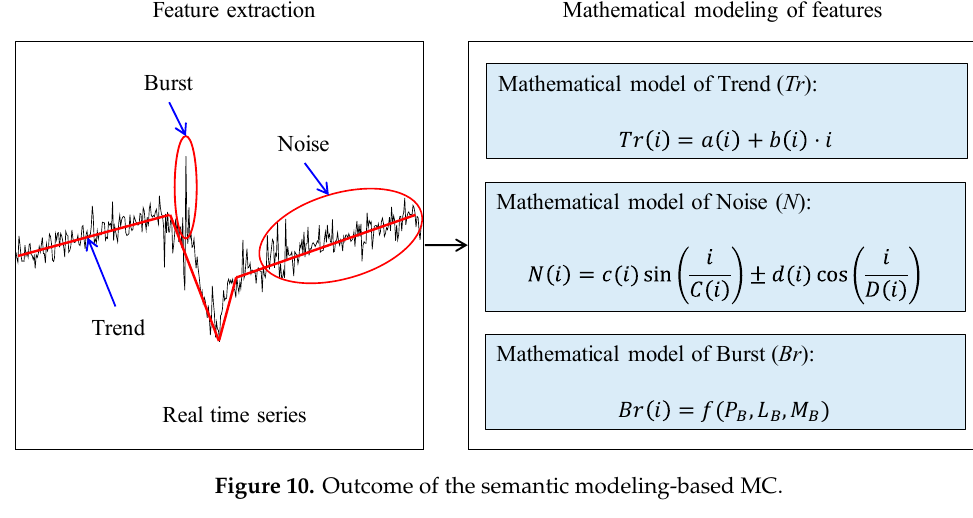
Figure 10. Outcome of the semantic modeling-based MC.